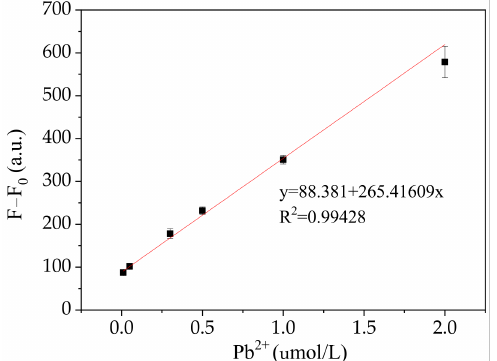
Figure 11. The relationship between the difference value of fluorescence intensities and the different concentrations of Pb 2+